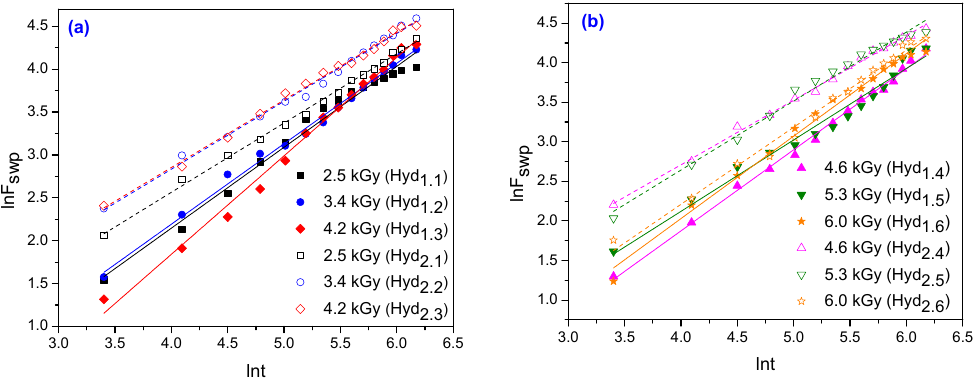
Figure 7. The plots of ln F versus ln t for hydrogels obtained at: ( a ) 2.5 kGy, 3.4 kGy and 4.2 kGy; ( b ) 4.6 kGy, 5.3 kGy and 6.0 kGy.